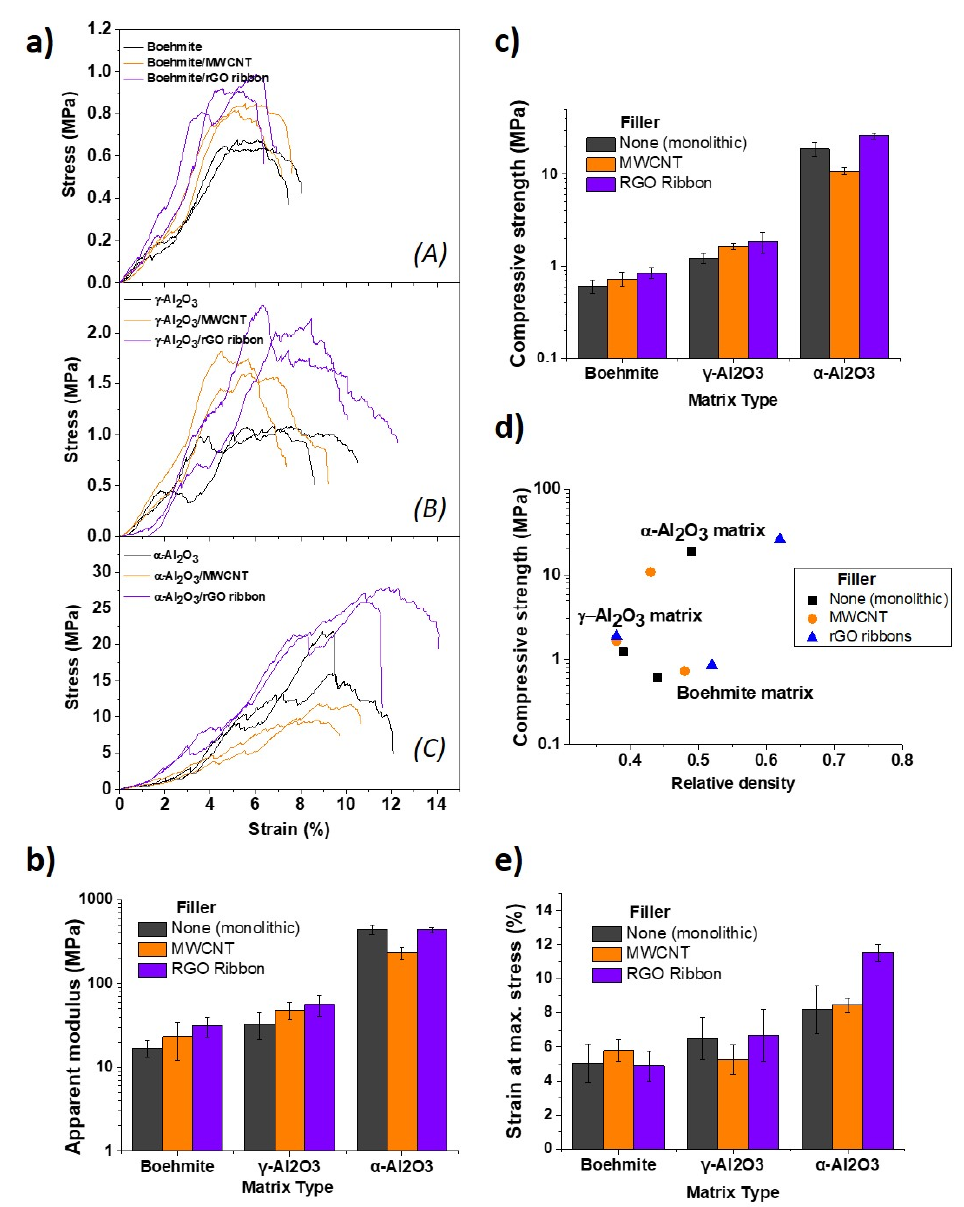
Figure 4. ( a ) Examples of stress–strain curves grouped by matrix material: (A) boehmite, (B) γ-Al 2 O 3 , and (C) α-Al 2 O 3 ; ( b ) apparent modulus, ( c ) compressive strength, ( d ) compressive strength and density, and ( e ) strain at maximum stress.